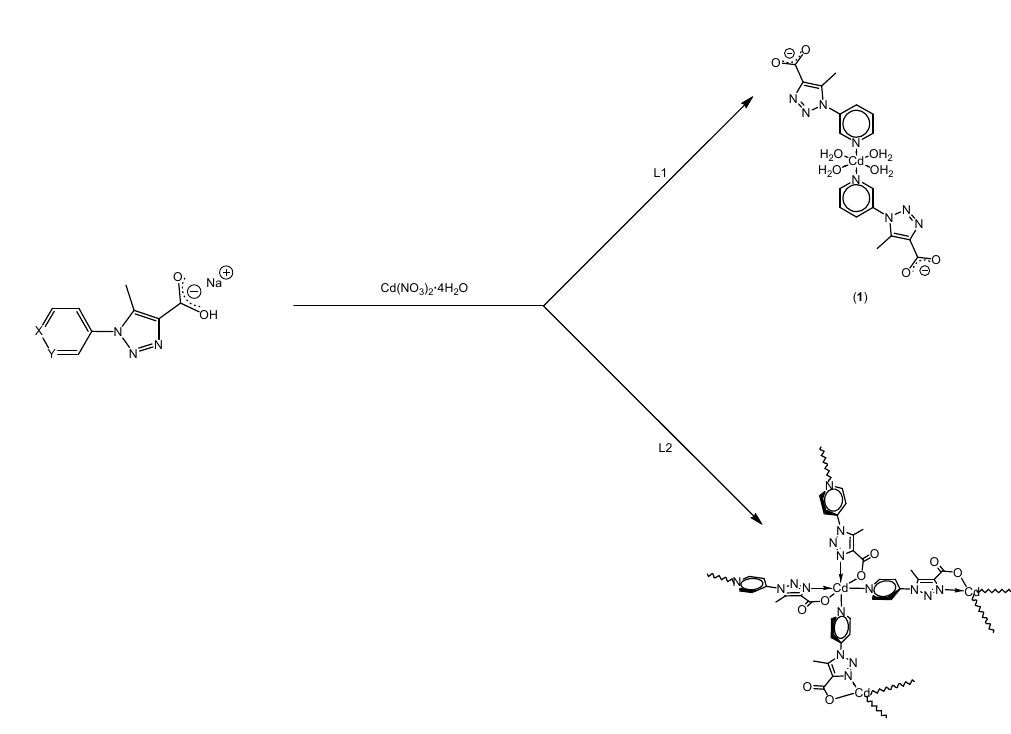
Figure 2. Crystal packing of compound L1H ( left ) and L2H ( right ). In compound 1 , the asymmetric unit contains a Cd(II) cation, two water molecules, and two molecules of L1 . The Cd(II) ion lies on an inversion center and is hexacoordinate with a [N 2 O 4 ] coordination sphere (four water molecules and two N donor atoms from the pyridyl moiety of L1 ) in a distorted octahedral geometry (see Figure 3). The bond lengths and angles around the Cd(II) ion are in the range of 2.280(3)–2.294(3) Å for Cd-O, and 2.358(4) Å for Cd-N. The angles O-Cd-O and O- Cd-N are 86.57(13)-180.0° and 88.59(14)-91.41(14)°, respectively. These bond lengths and angles are similar to the reported values of related Cd(II) complexes containing carboxylate and pyridyl fragments [39,40]. Compound 1 exhibits parallel packing, generating a slab along the (101) plane (see Figure 4). Moreover, an induced hydrogen bond framework in the whole cell generates a spiral shape, due to the 2 1 -screw axis and perpendicular glide plane. The hydrogen bonding interactions along the slab are located between water molecules in the equatorial positions of the coordination core and carboxylate fragments, specifically the O(3) and O(4) atoms. The coordinated water molecules and the carboxylate groups are involved in the formation of a two-dimensional hydrogen-bonded network, which consolidates the crystal packing (see Figure 4). Figure 3. View of local coordination geometry at the Cd(II) center in compound 1 (30% ellipsoid probability). Symmetry code (i) is 1 − x,1/2 + y,3/2 − z.